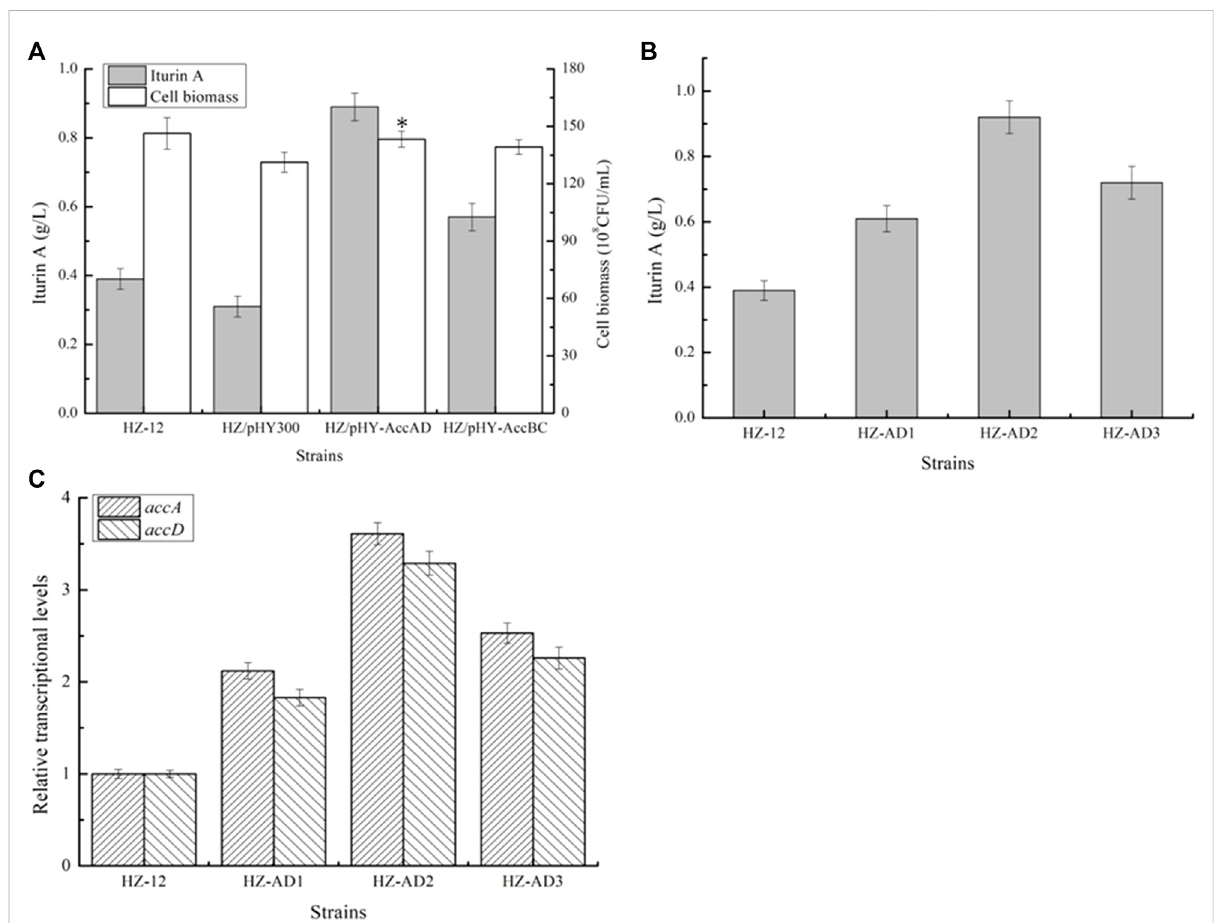
FIGURE 2 Effect of acetyl-CoA carboxylase overexpression on iturin A production. (A) Effects of strengthening AccAD and AccBC expressions on iturin A production. (B) Iturin A yields of AccAD overexpression strains mediated by different promoters. (C) Transcriptional level